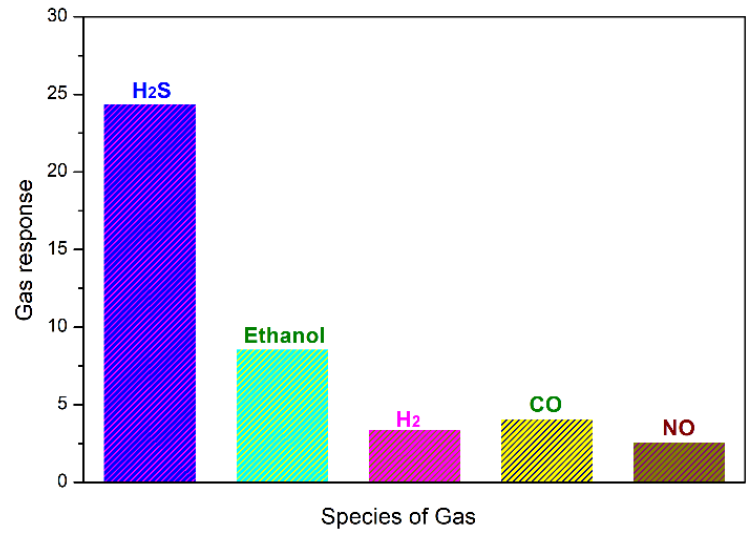
Figure 6. Selectivity of the network nanowire-based gas sensor to different gas at 50 ppm.